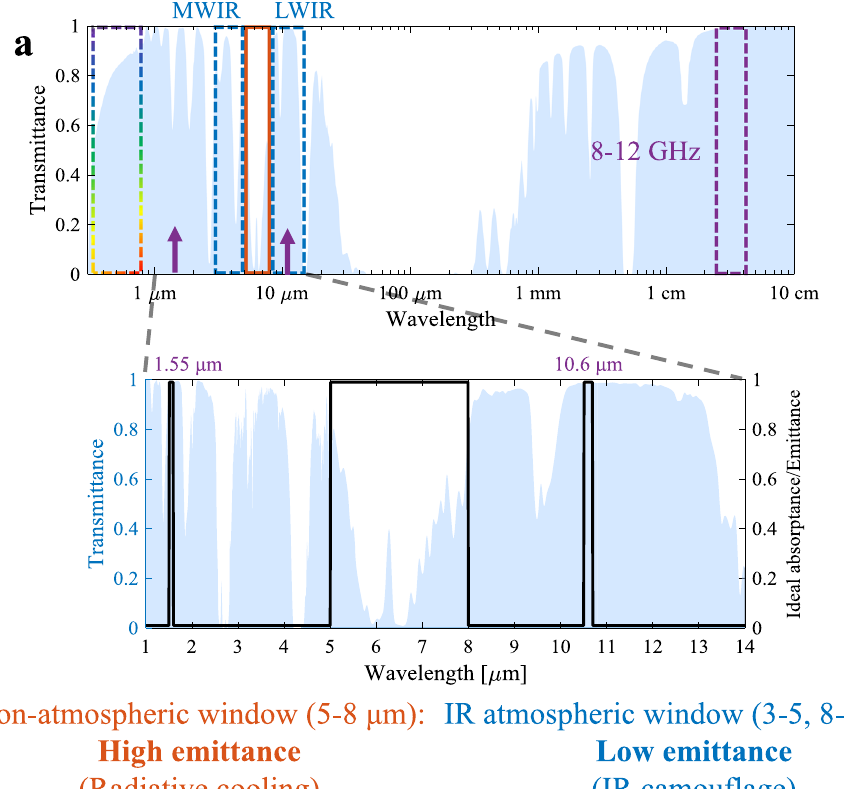
NATURE COMMUNICATIONS| (2021) 12:1805 |https://doi.org/10.1038/s41467-021-22051-0|www.nature.com/naturecommunications